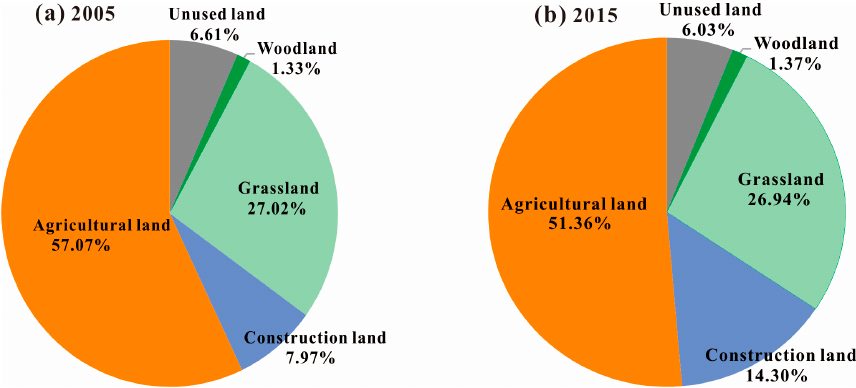
Figure 4. Pie charts of areas of land use types in 2005 ( a ) and 2015 ( b ).